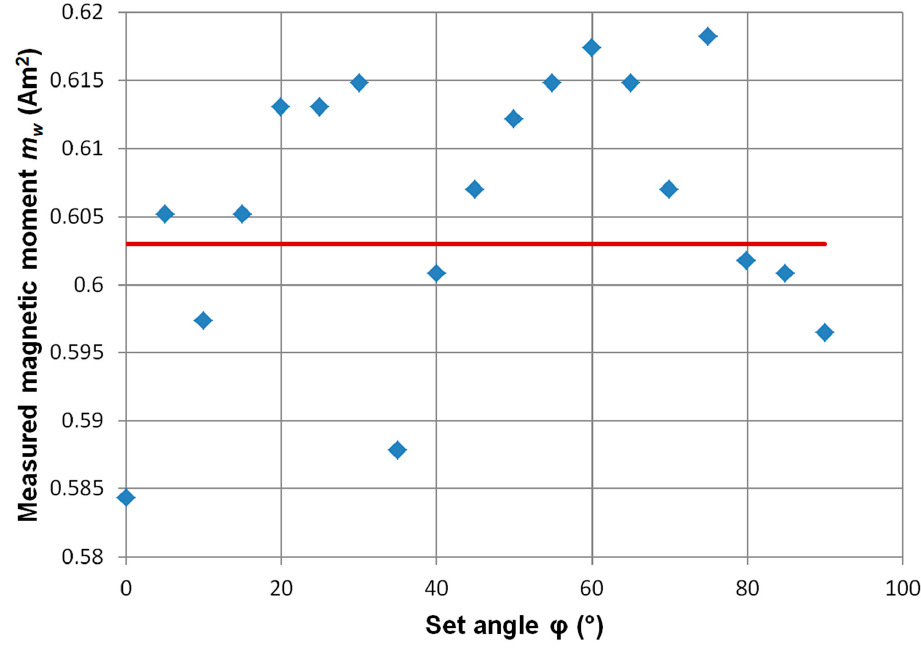
Figure 8. Dependence of the determined magnetic moment value of the object on the set angle ϕ . Set coordinates of the ME8 standard ( x 0 , y 0 , z 0 ) = (0, 0, 140) mm. Red line—the m value of the object.